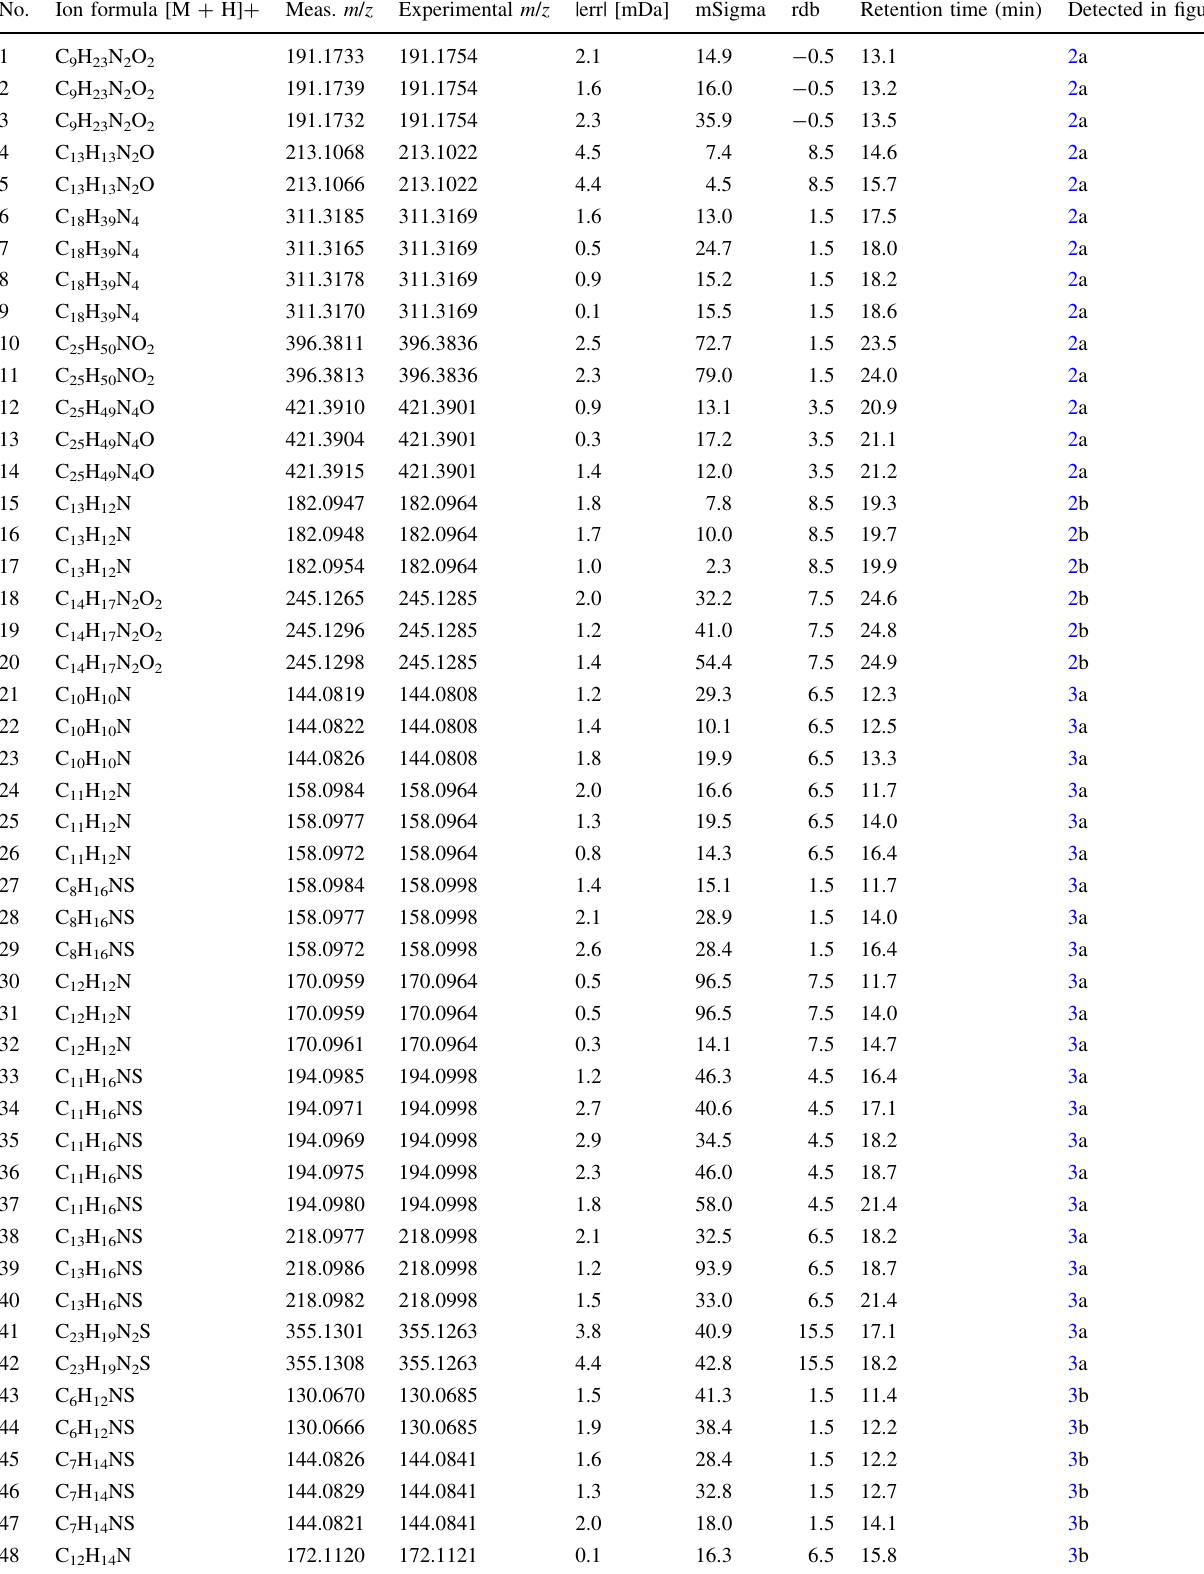
Table 2 Isomeric compounds detected in Fig. 2 and Fig. 3